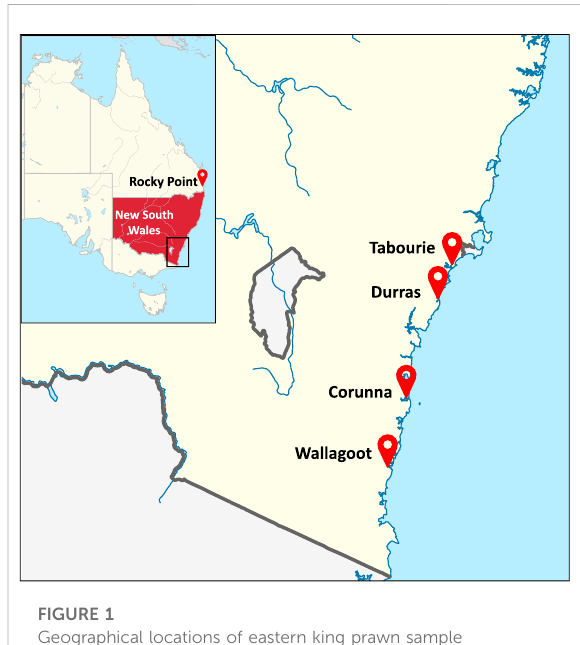
FIGURE 1 Geographical locations of eastern king prawn